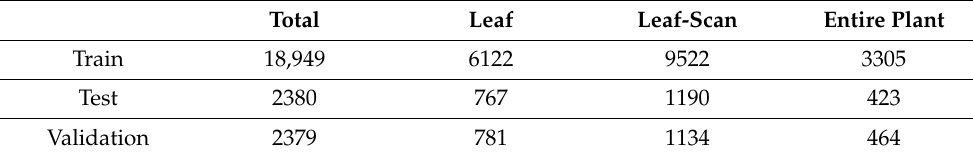
Table 1. Number of images extracted from PlantCLEF 2015 dataset. Total Leaf Leaf-Scan Entire Plant